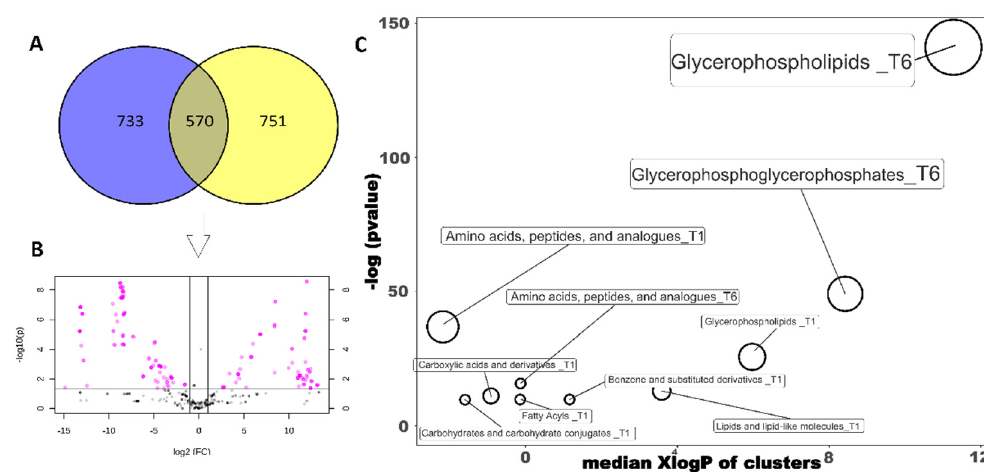
Figure 3. Non-heat-treated sample group; ( A ) Venn analysis built by intersecting compounds of inoculated samples incubated at 24 (blue) and 144 (yellow), using up-regulated metabolites (FC >2) compared to non-inoculated samples incubated 24 and 144 h. ( B ) Volcano plot analysis ( p -value < 0.05 and FC > 2) on 570 common VIP marker compounds identified at both 24 h and 144 h time points. ( C ) Chemical enrichment analysis generated from the significant compounds: T1 = significant chemical class for inoculated samples at 24 h; T6 = significant chemical class for inoculated samples at 144 h.